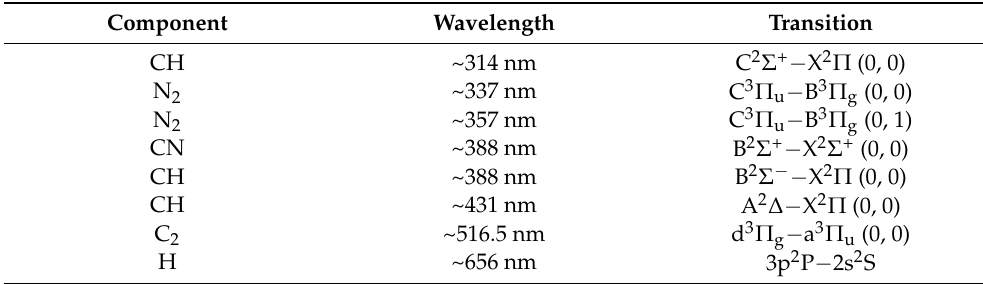
Figure 2. ( a ), Photo of femtosecond laser filament in a gas mixture. A femtosecond laser was used with a pulse energy of 2 mJ, a wavelength of 800 nm, a pulse duration of ~45 fs and a repetition rate of 1 kHz. The total gas flow rate was 4.24 × 10 − 4 m 3 /s, the gas flow speed was 0.15 m/s, and the equivalence ratio was 1. ( b ), the spatially resolved spectral graph of the filament, where the X-axis represents the wavelength, the Y-axis represents the spatial position, and the color bar on the left represents the relative intensity of the signal. ( c ), the spectral curve obtained from the accumulation of the spectral graph. Table 2. Energy level transitions of main signals of femtosecond filaments in premixed methane/air